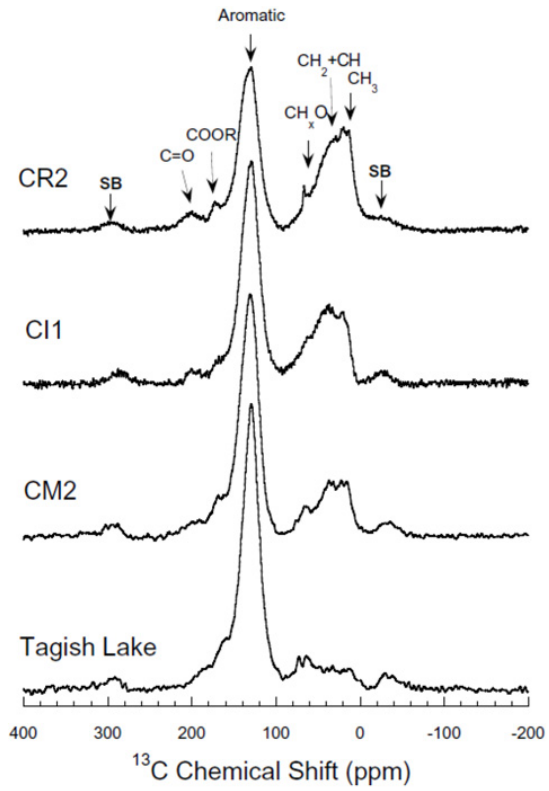
Figure 5. Solid state 13 C NMR spectra of IOMs from carbonaceous chondrites of various degrees of hydrothermal alteration [61]. The least altered meteorite is on the top, the most altered is at the bottom. From the NMR spectra, it appears a clear decrease in the aliphatic C content with increasing alteration. This has been interpreted as a loss of aliphatic carbons by oxidation during the aqueous